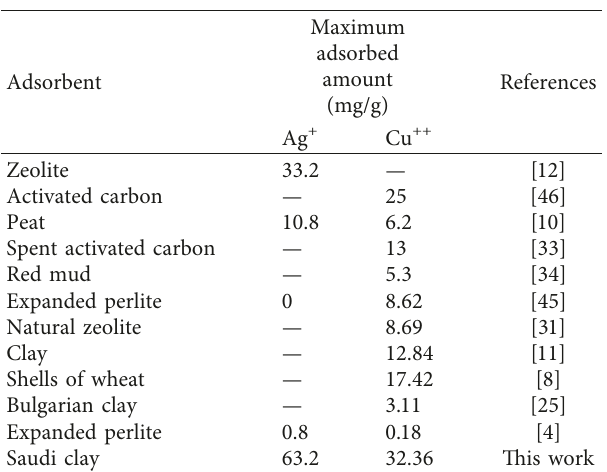
Table 3: Comparison of adsorption capacity of Saudi clay with other adsorbents reported in previous works.